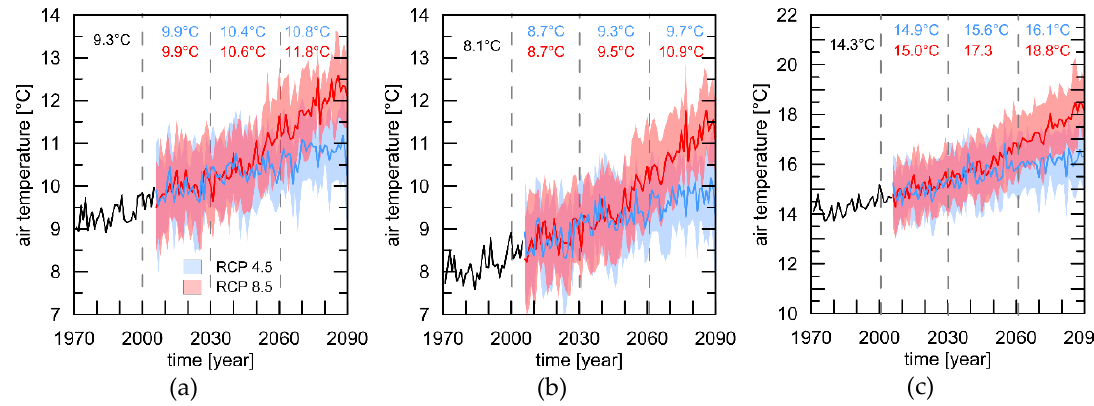
Figure 1. Multi-model ensemble of mean annual air temperature values for London (a), Luxembourg (b), and Rome (c) based on two different Representative Concentration Pathways (RCPs) (4.5 = blue; 8.5 = red). Spread is defined via +/- one standard deviation of the ensemble. Please note that the scale of Figure 1c is different from a and b.